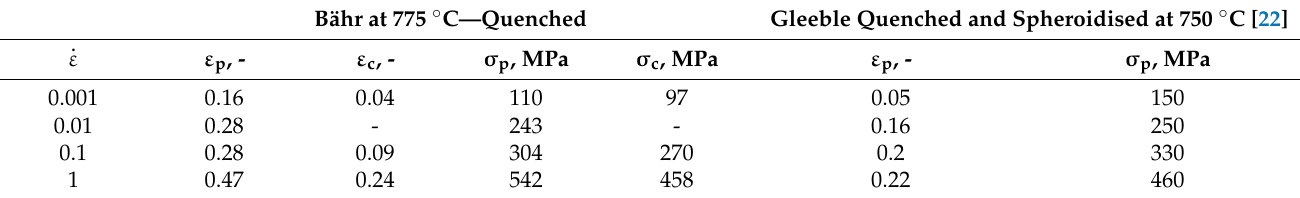
Table 3. Comparative data for warm testing quenched and spheroidized quenched Fe-0.85Mo-0.65Si-1.4C. Bähr at 775 ◦